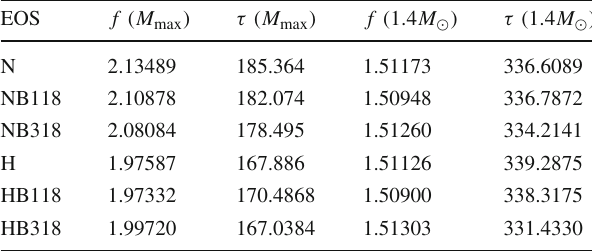
Table 5 Frequency and damping time for the maximum mass and the canonical star EOS